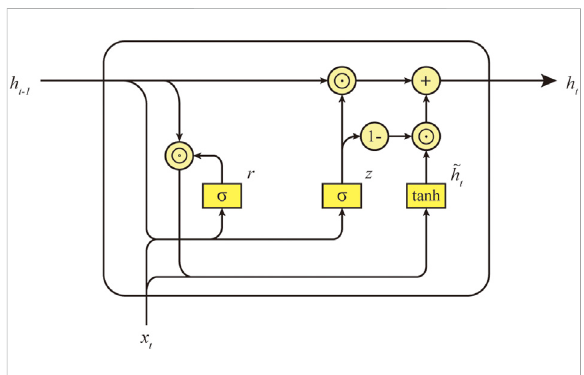
FIGURE 3 Compute the hidden state of the GRU model. Update gate z chooseswhetherto updatetheoutputhiddenstate h t withhidden state ~ h t . Reset gate r decides whether to ignore the hidden state h t − 1 of the previous time step.